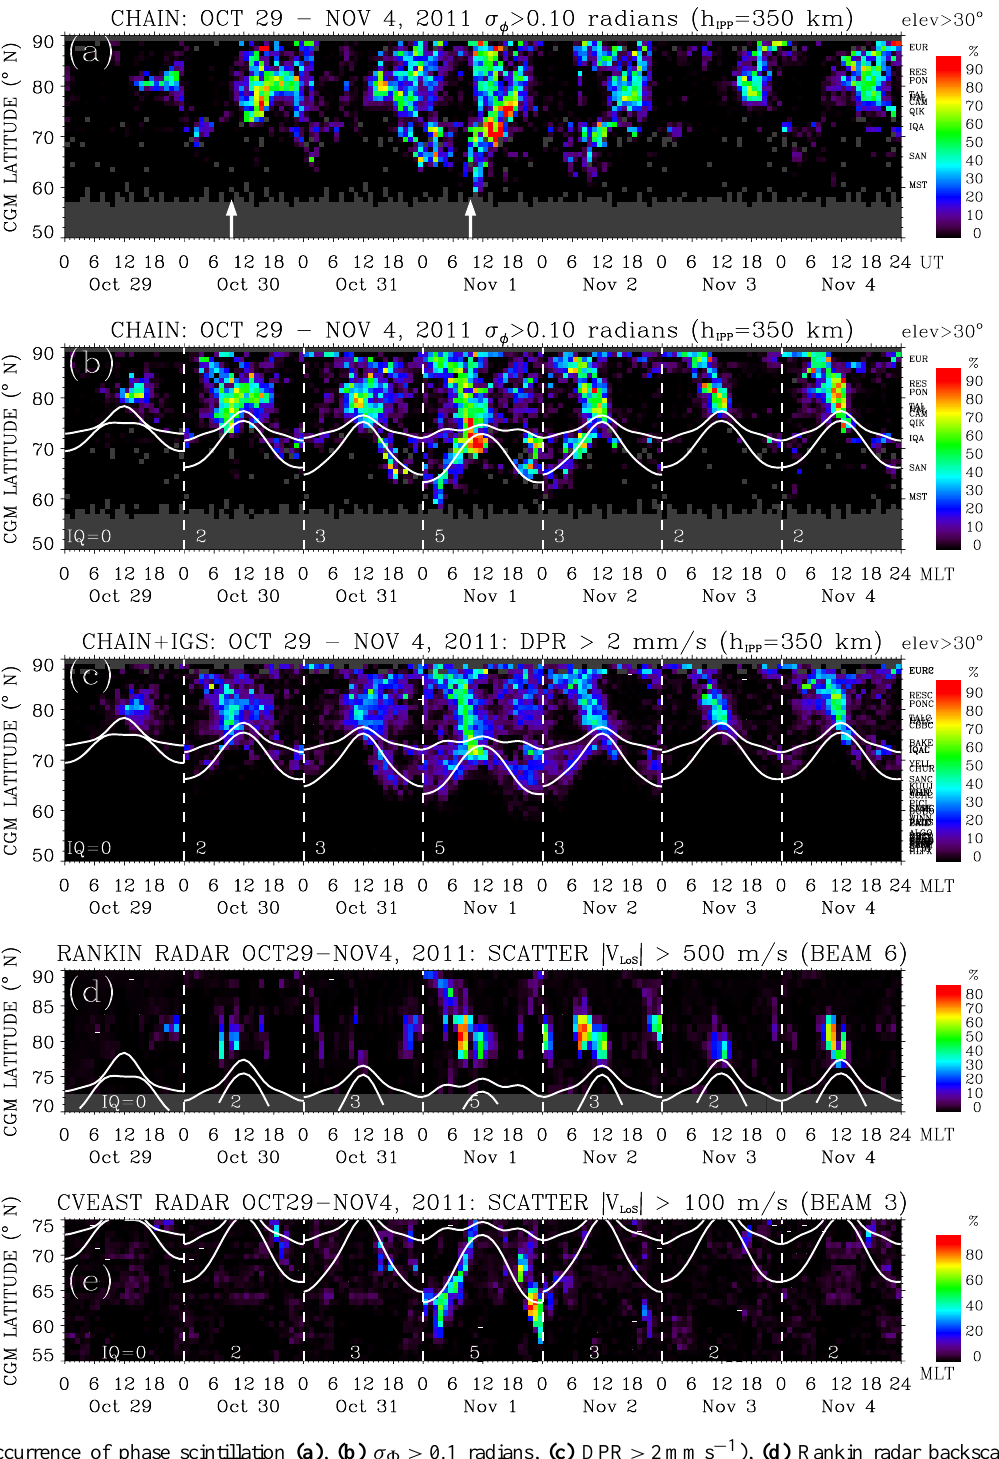
Fig. 6. The occurrence of phase scintillation (a) , (b) σ 8 > 0 . 1 radians, (c) DPR > 2mms − 1 ), (d) Rankin radar backscatter ( V LOS > 500ms − 1 ) and (e) Christmas Valley East radar backscatter ( V LOS > 100ms − 1 ) from 29 October to 4 November 2011. The maps are shown as a function of CGM latitude and (a) UT or (b) – (e) MLT. White arrows in the top panel indicate the arrival time in UT of two ICMEs. The statistical auroral ovals with IQ values approximately proportional to daily values of Kp index are